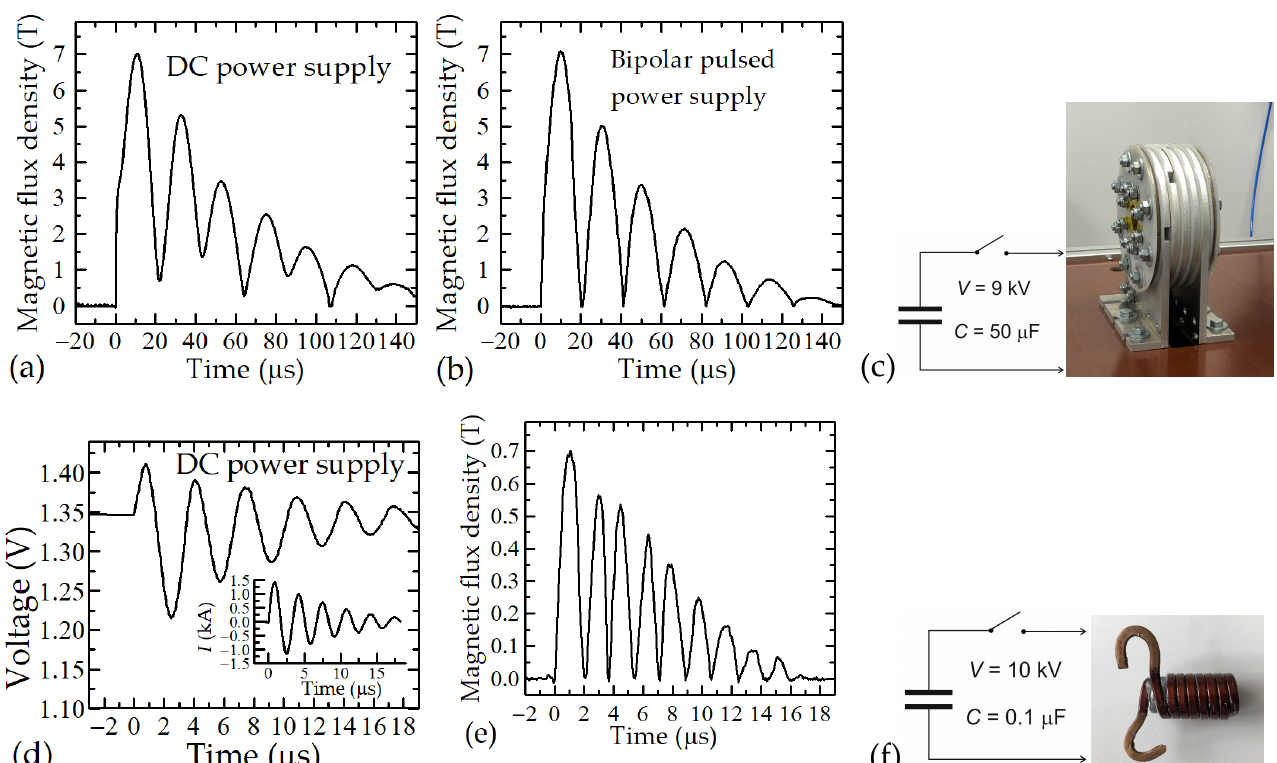
Figure 12. ( a ) magnetic field dynamics inside the Bitter coil when measurement was performed us- ing the DC supply of the sensor; ( b ) magnetic field dynamics, when measurement was made by the new measurement system; ( c ) block diagram of magnetic field generation system with Bitter coil (see picture); ( d ) voltage change across the sensor positioned inside the two-layer coil when it was supplied by DC voltage; ( e ) magnetic field dynamic inside the two-layer coil when measurement was performed using the new measurement system; ( f ) block diagram of magnetic field generation system with two-layer coil (see